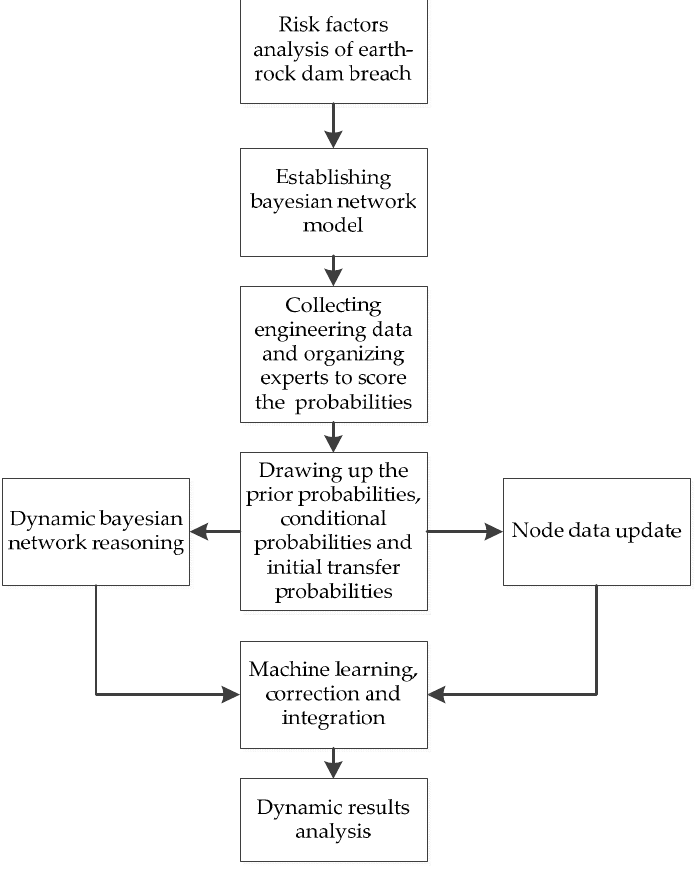
Figure 4. Risk assessment procedure for the dam breach of the earth-rock dam.